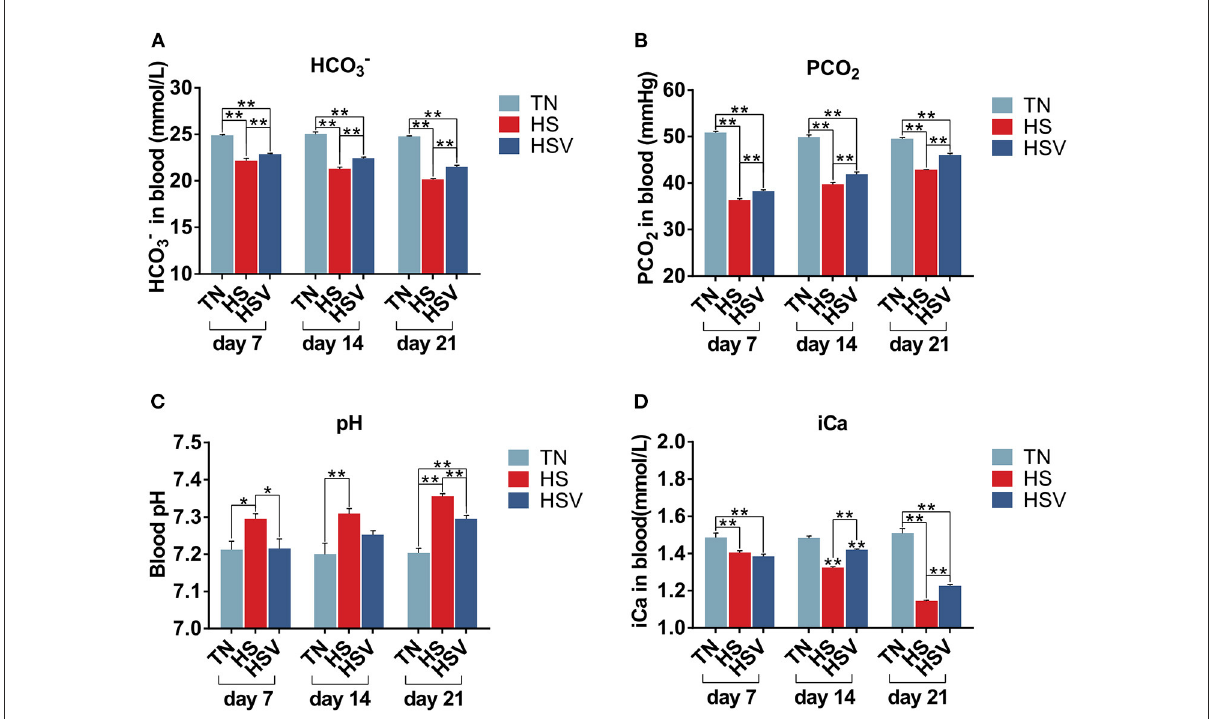
FIGURE2 Effects of vitamin C on blood gas indexes in chronically heat-stressed laying hens. (A) blood chemistry parameters of HCO − 3 ; (B) blood chemistry parameters of PCO 2 ; (C) blood chemistry parameters of pH; and (D) blood chemistry parameters of